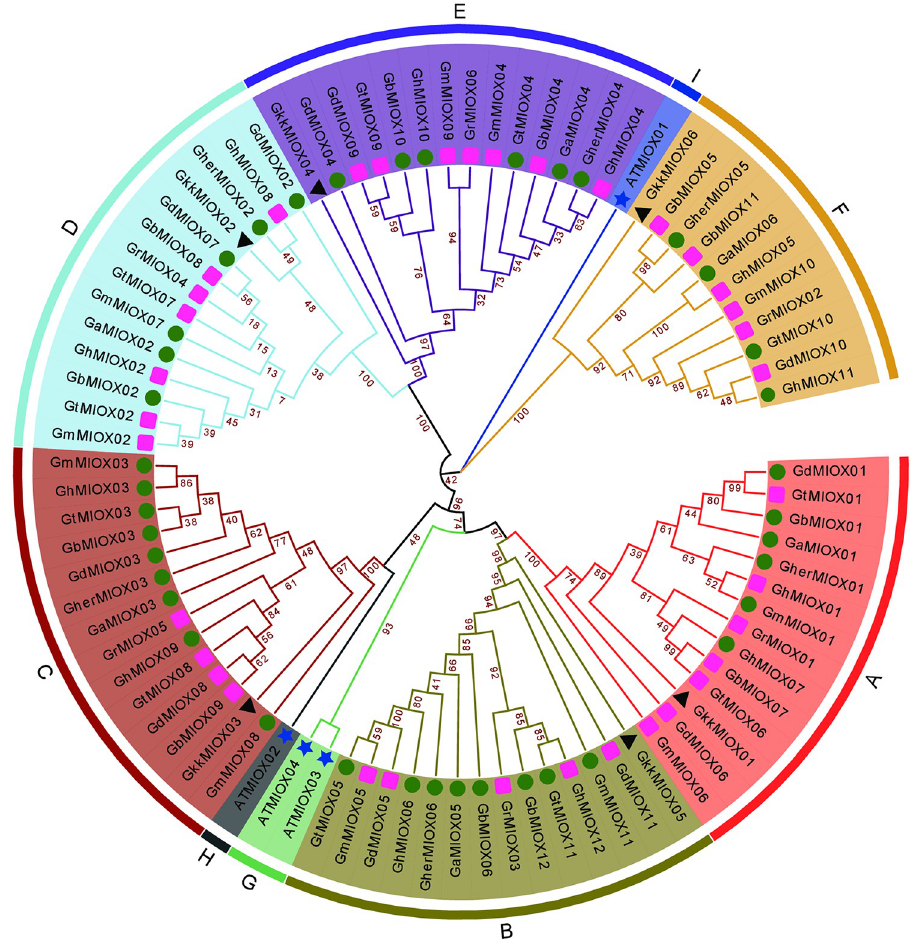
Fig 1. Phylogenetic tree of MIOX proteins from 8 Gossypium species, Gossypioides kirkii and Arabidopsis thaliana . The different-colored arcs indicate different groups of MIOX proteins. The green circles and red boxes represent MIOX proteins from A genome and D genome, respectively, black triangles represent MIOX proteins from Gossypioides kirkii , blue stars represent MIOX proteins from Arabidopsis thaliana